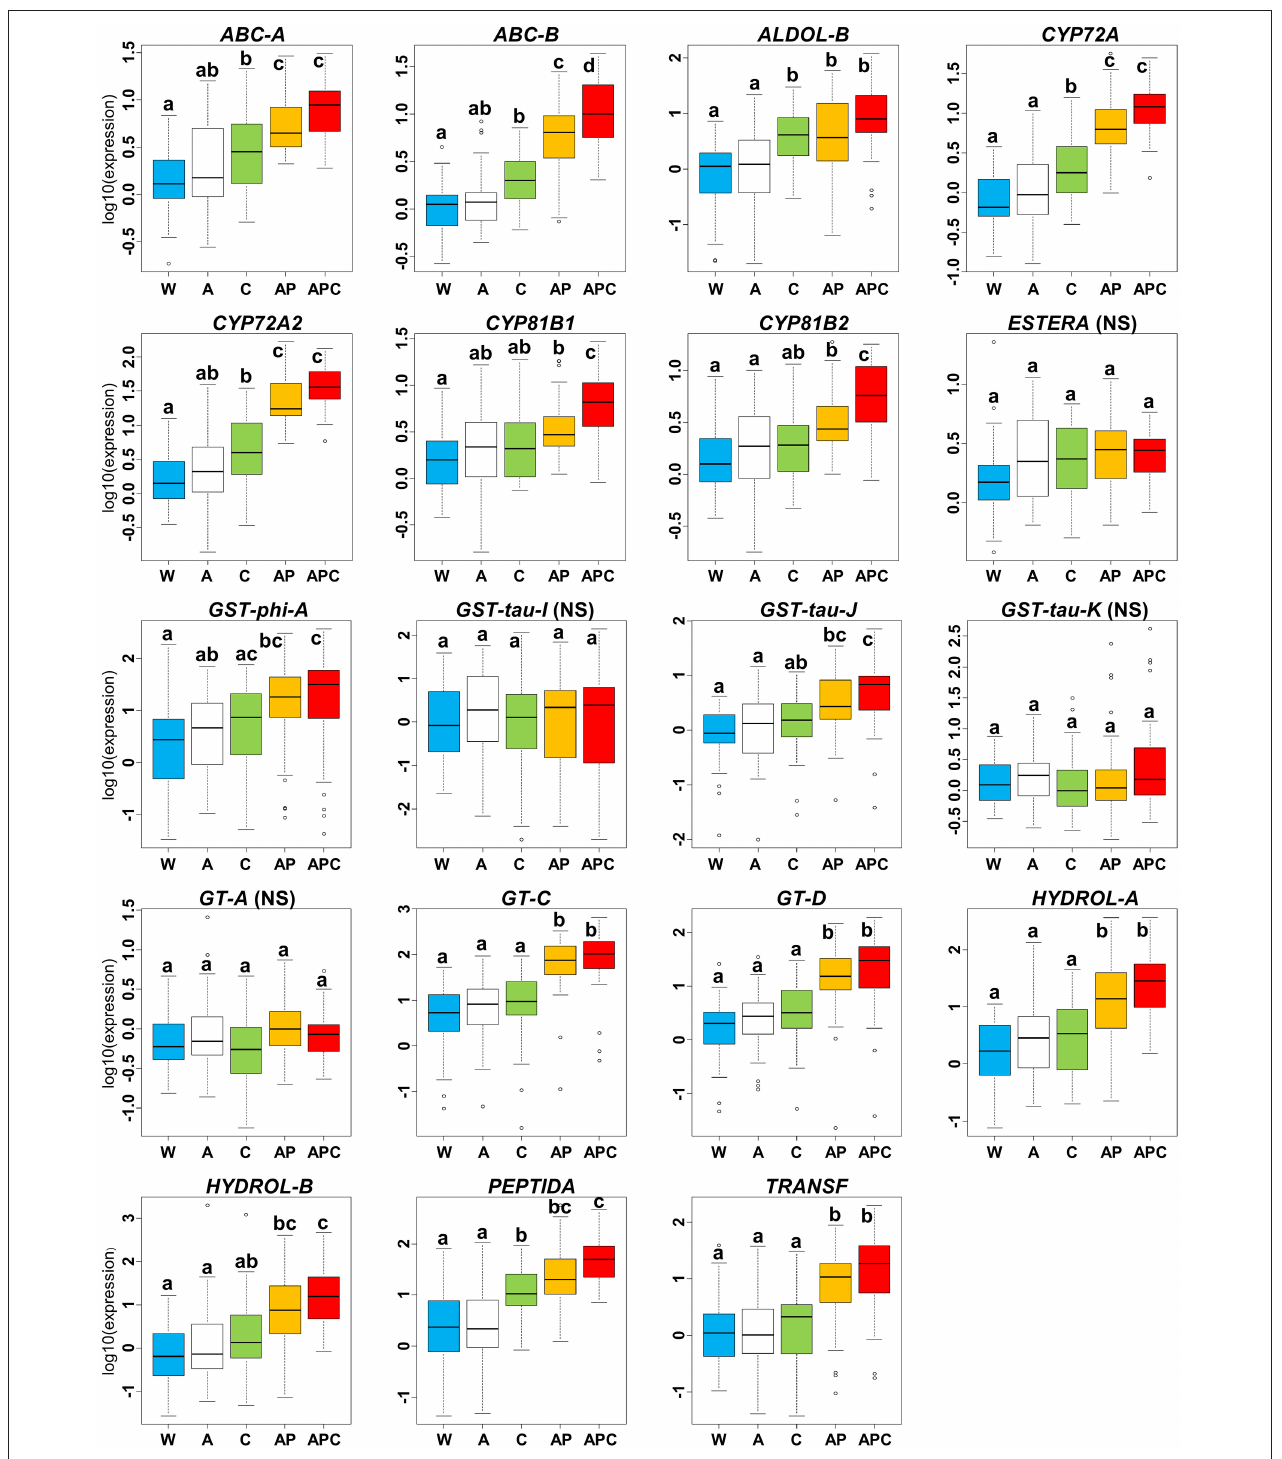
FIGURE 4 | Variation of relative expression levels of 19 NTSR marker genes among experimental modalities in the pyroxsulam and cloquintocet-mexyl experiment. Expression levels 24 h after treatment are averaged over the 36 rye-grass plants studied. Experimental modalities: W, water; A, Actirob (adjuvant recommended for herbicide application); C, cloquintocet-mexyl; AP, pyroxsulam + Actirob; APC, pyroxsulam + cloquintocet-mexyl + Actirob. For each marker, different letters indicate significantly different expression levels (Tukey’s test, p < 0.05). NS, marker for which no significant effect of the experimental modality was detected in ANOVA ( Table 3